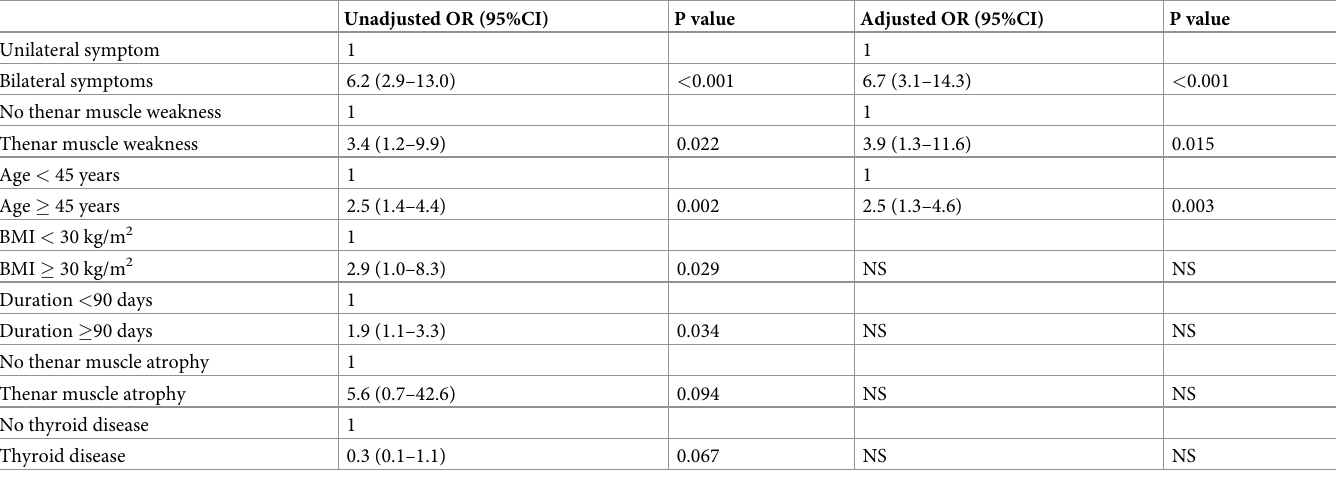
Table 4. Unadjusted and adjusted odds ratio between different variable and bilateral